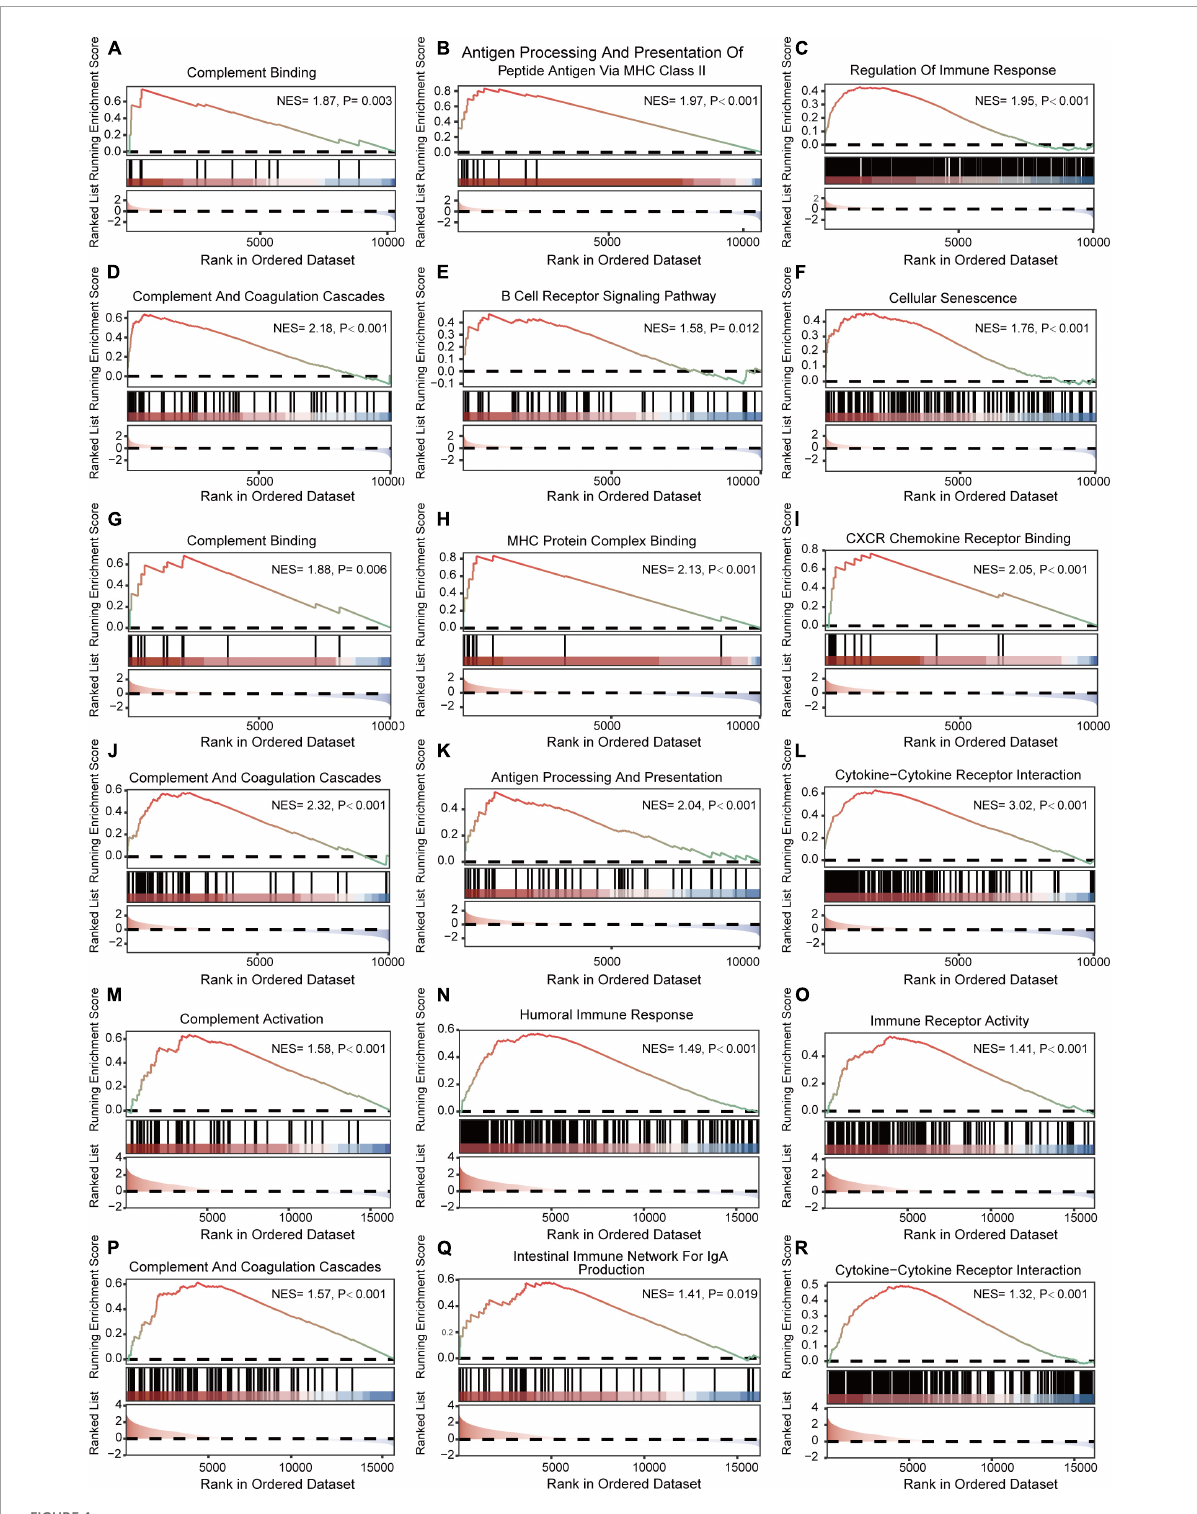
FIGURE4 GSEA enrichment analyses of GSE24982, GSE63442, and GSE63651. (A–C) Immunity-related GO items enriched in pain based on GSE24982. (D–F) Immunity-related KEGG pathways and cellular senescence enriched in pain based on GSE24982. (G–I) Immunity-related GO items enriched in pain based on GSE63442. (J–L) Immunity-related KEGG pathways enriched in pain based on GSE63442. (M–O) Immunity-related GO items enriched in aging based on GSE63651. (P–R) Immunity-related KEGG pathways enriched in aging based on GSE63651. GSEA, Gene set enrichment analysis; NES, Normalized enrichment score; P, p